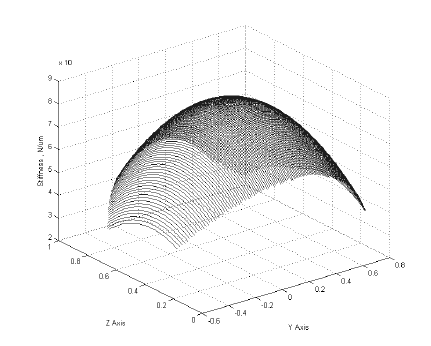
Figure 16: The Cartesian stiffness in the X-direction as function of the Y- and